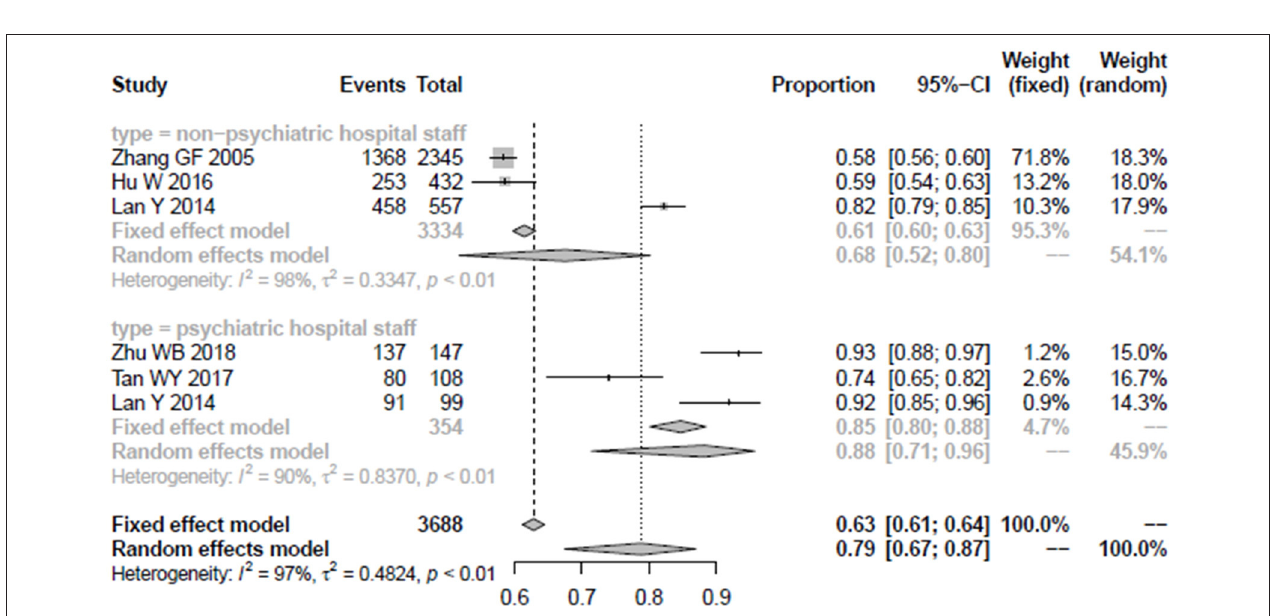
FIGURE 5 | The forest plot of awareness rate among psychiatric staff and non-psychiatric staff.